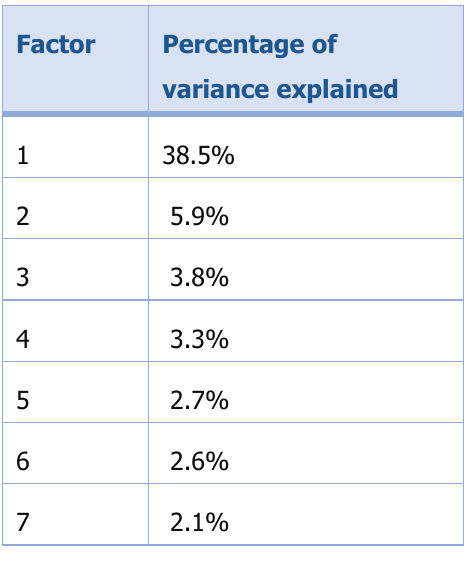
Table 4. Percentage of Variance Explained by